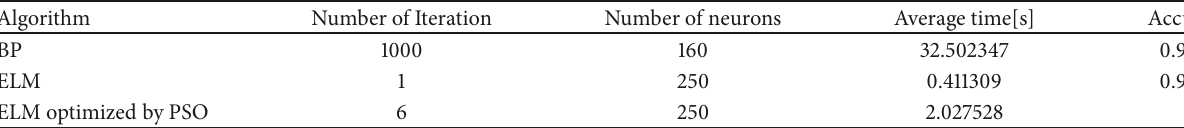
Table 1: The performance comparison of three models.